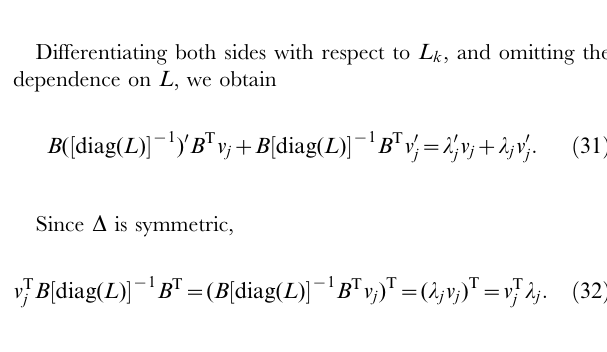
Figure 5. Error between perturbative/iterative solutions and reference solution. The reference solution has been computed via numerical time integration. We plot the log of the error as a function of the number of iterations. As shown in Figures 6 and 7 together with Tables 4 and 5, the perturbative/iterative solutions are more accurate than the reference solution. This explains why, in the above plot, the perturbative and iterative solutions do not converge to the reference solution.